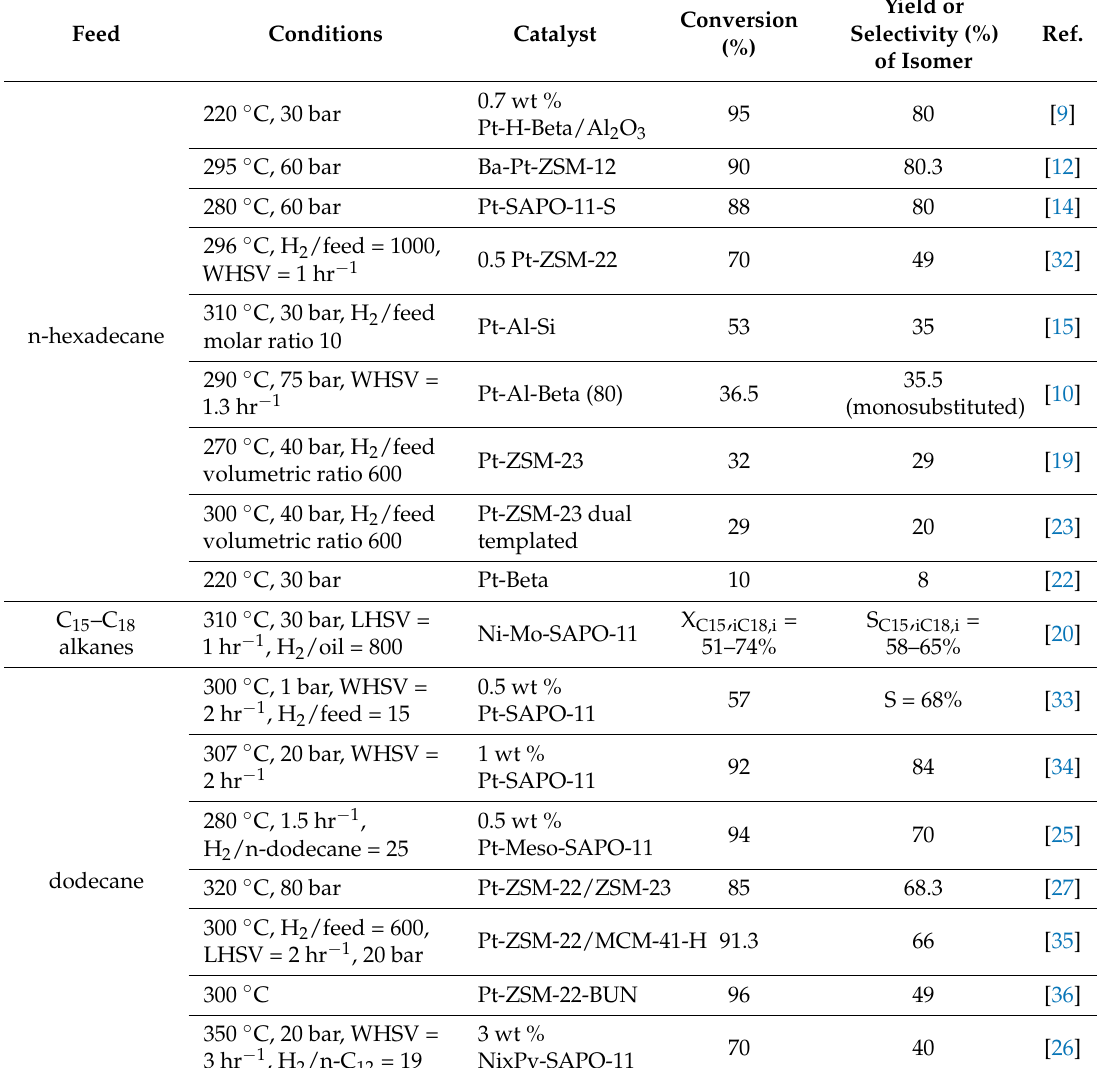
Table 1. The highest yield of isomers in hexadecane and dodecane hydroisomerization over different catalysts at optimum reaction conditions and conversion levels.